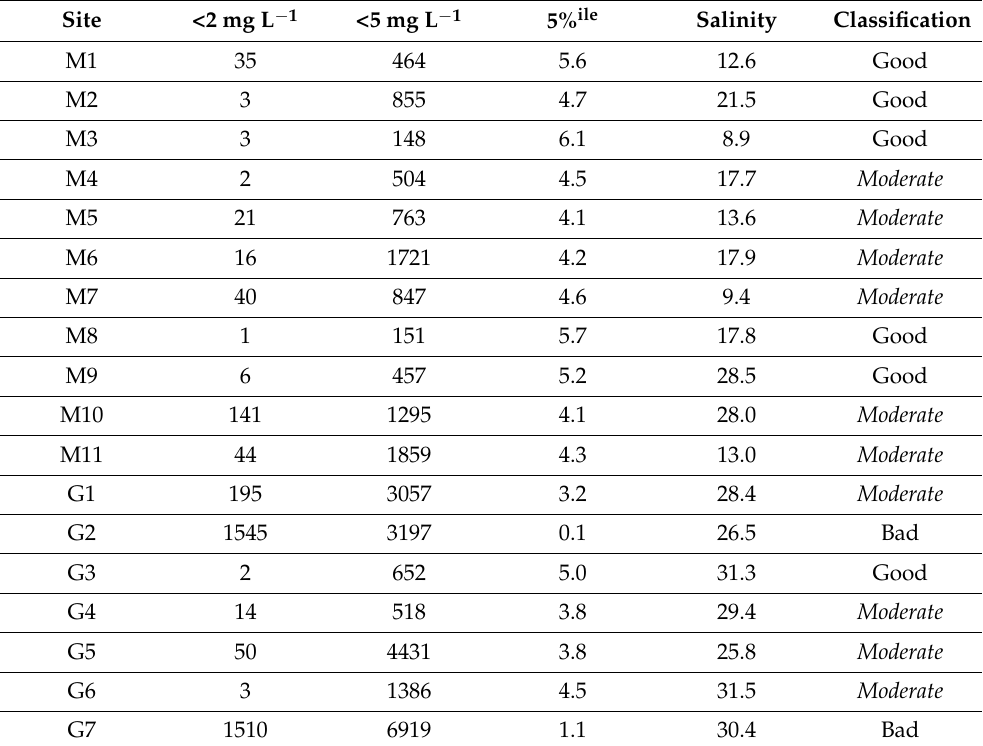
Table 2. Classification of investigated sites on the basis of salinity DO mixing curves proposed by Best et al.